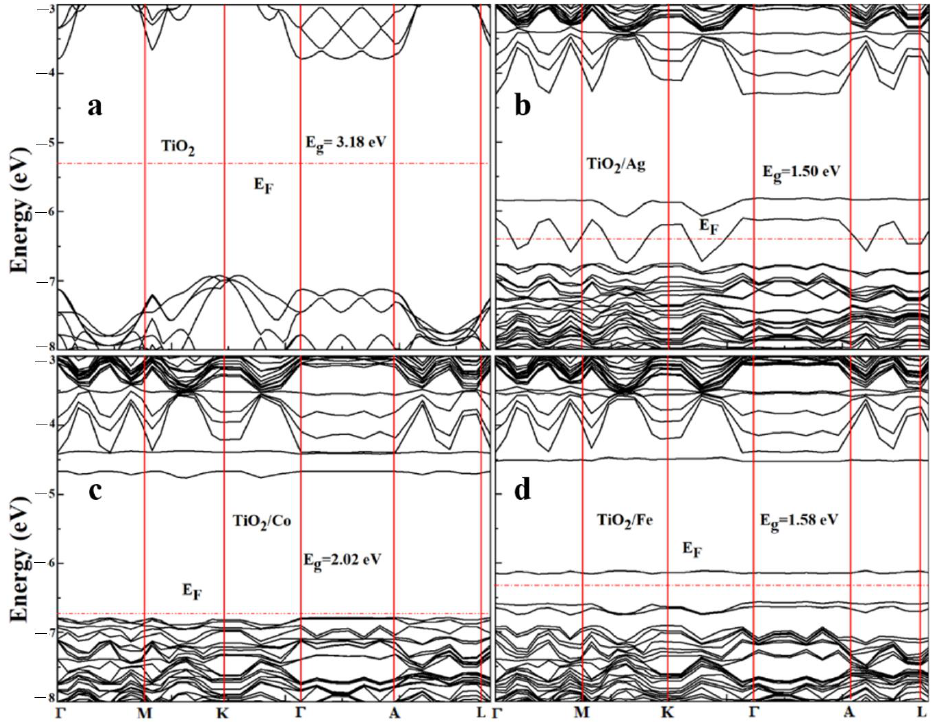
Figure 3. Band structure of ( a ) pristine and ( b ) Ag-, ( c ) Co-, and ( d ) Fe-doped TiO 2 . Furthermore, TiO 2 /Ag, TiO 2 /Co, and TiO 2 /Fe showed direct bandgaps of 1.50, 2.02, and 1.58 eV, respectively, along the high-symmetry directions of the Brillouin zones and were in good agreement with another work, as shown in Table 2 [43,44]. Table 2. Comparative bandgaps of pristine and doped TiO 2 anatase.